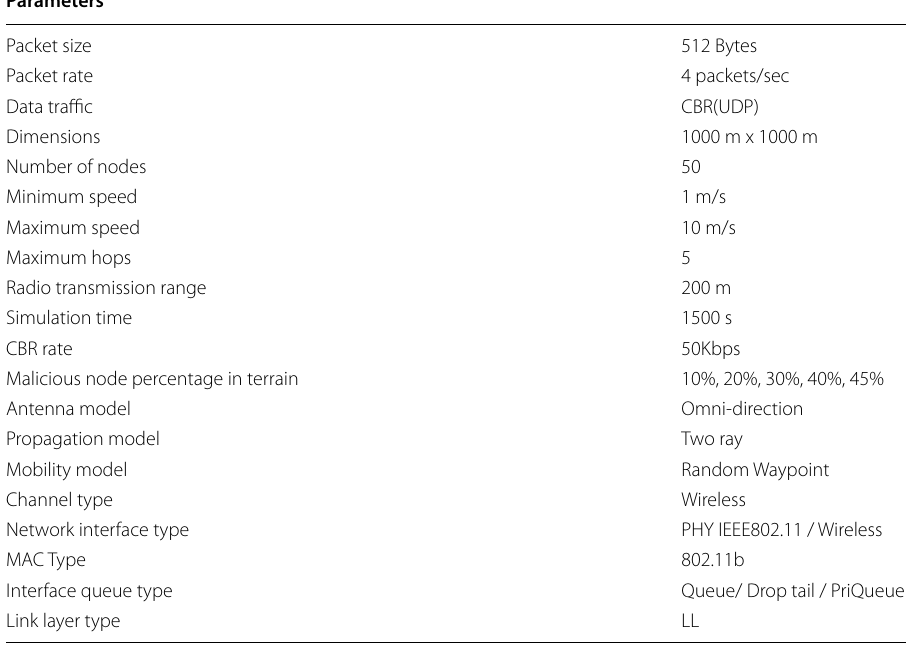
Table 5 Parameters for simulation